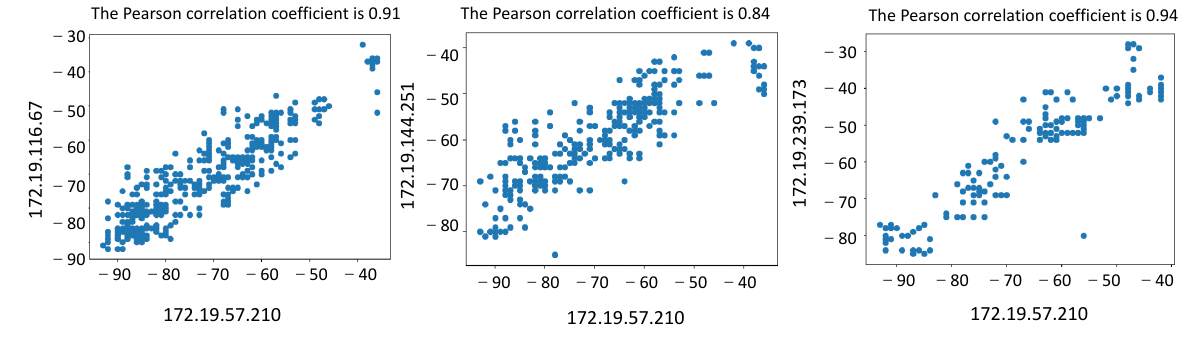
Figure 9. Calculation of Pearson’s correlation coefficient at a user distance of 1 m.